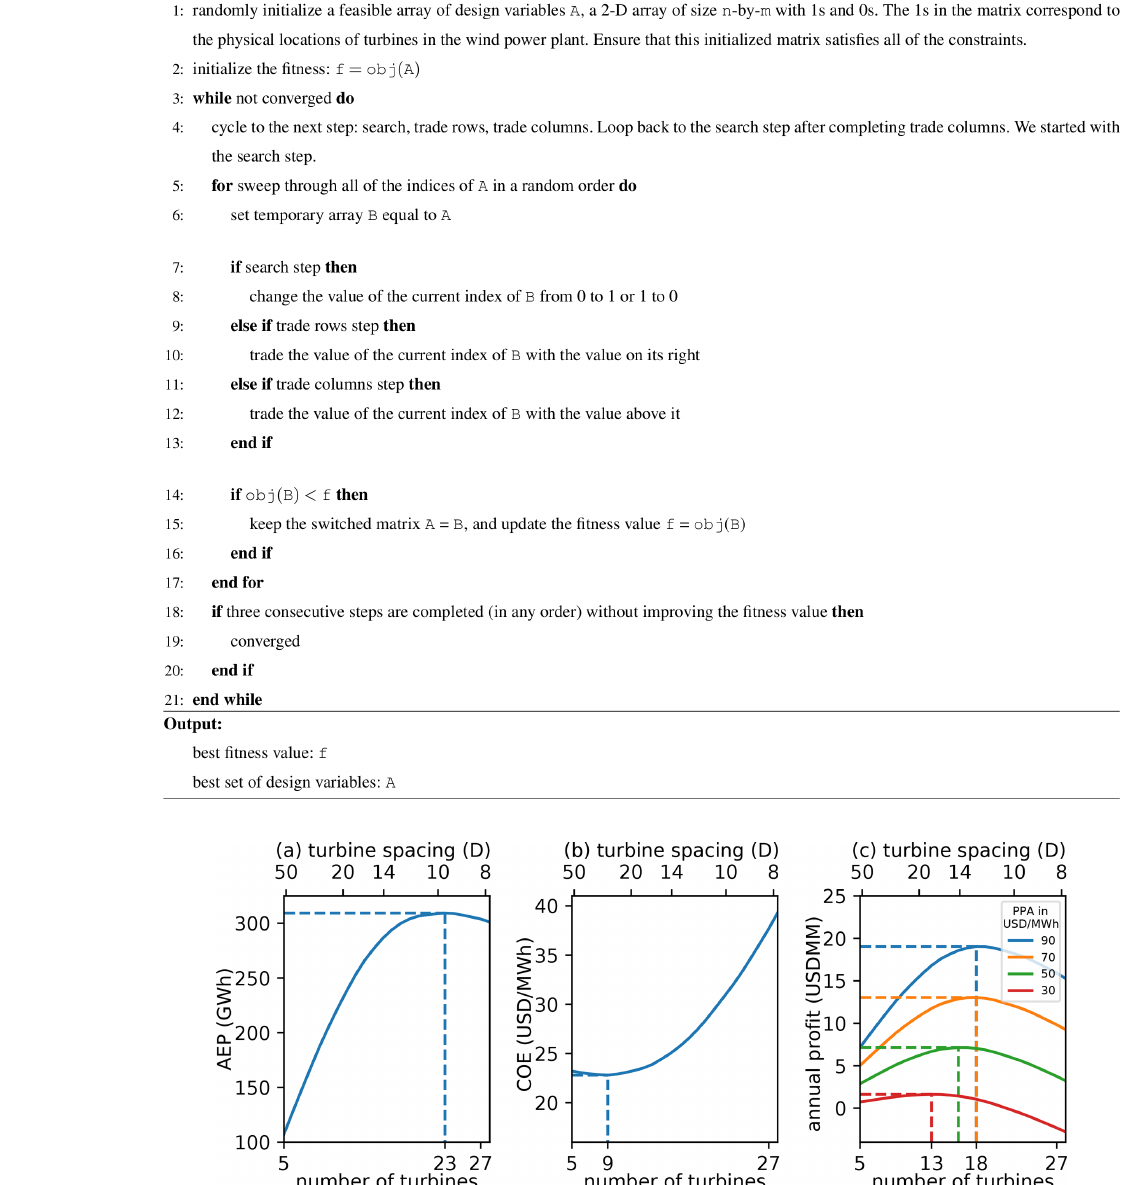
Figure 6. Different objectives as a function of the number of turbines in the wind power plant. For this example, the turbines are in line with the wind direction and are equally spaced in a wind power plant with a fixed length. From left to right, the objectives represented here are annual energy production (AEP), cost of energy (COE), and annual